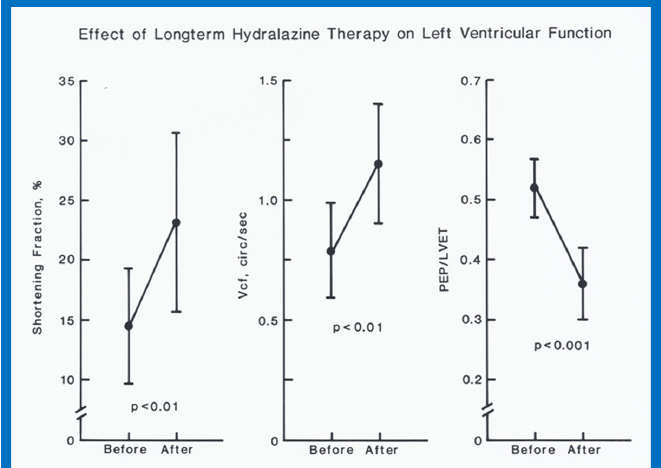
Figure 37. Left ventricular (LV) function indices, namely shortening fraction in percent (%) (left panel), velocity of circumferential fiber shortening (Vcf) in circumferences / sec (center panel) and pre-ejection period (PEP) / LV ejection time (LVET) ratio (right panel) prior to (Before) and following (After) hydralazine therapy are illustrated. Means and standard deviations are shown. Note the significant ( p < 0.01 to 0.001) improvement in all LV function indices. Circ: circumferences.